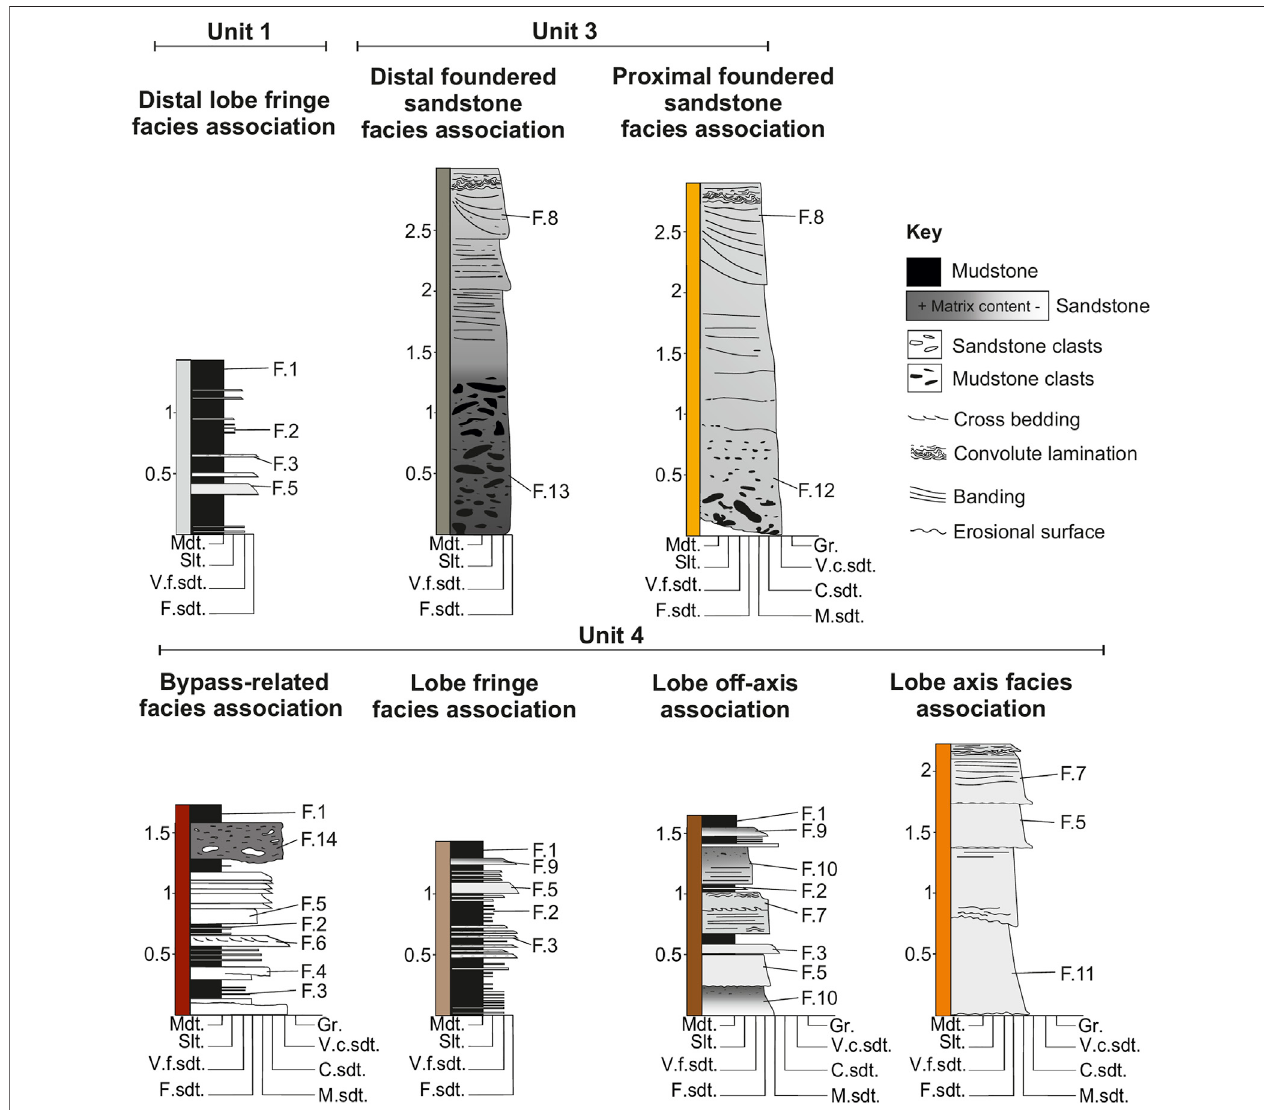
FIGURE 7 | Facies associations of Units 1, 3 and 4. See Table 1 and Panels 4 , 6 for more detail. See Panel 8 for the lateral variability of each facies association.